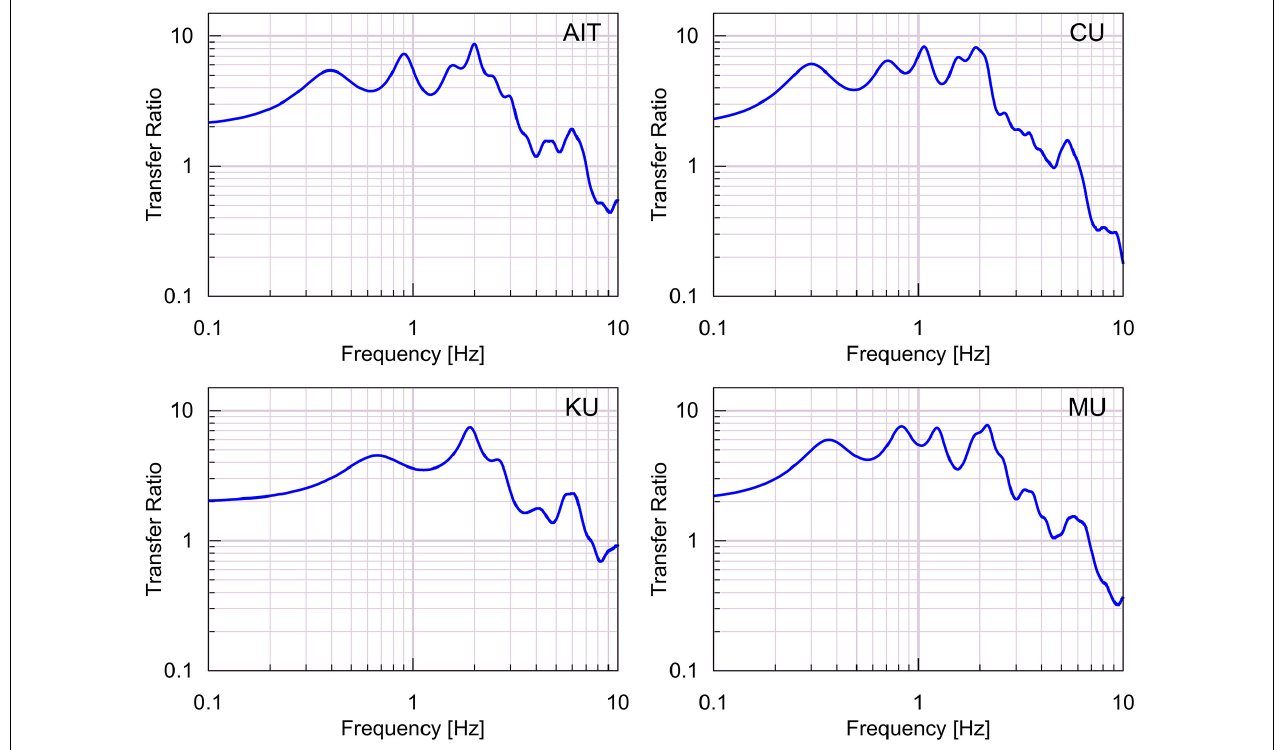
FIGURE 11 | 1-D linear transfer function from the multiple reflection analysis of the inverted models.